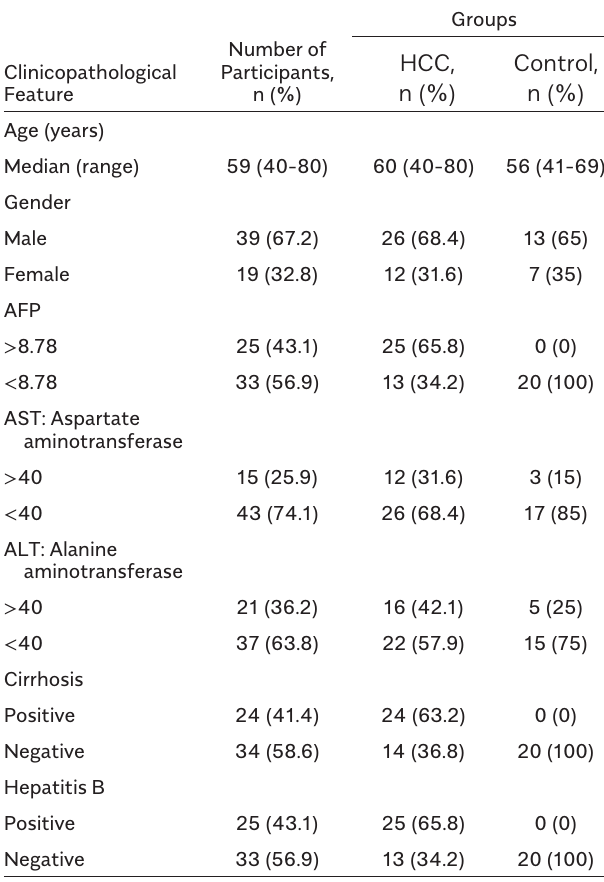
Table 1. Clinical Features of the Study Population